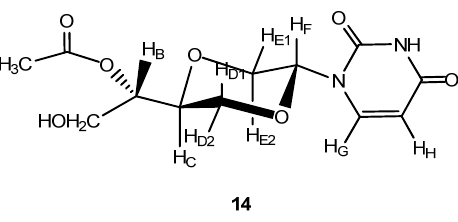
Figure 8. Structure of compound 14